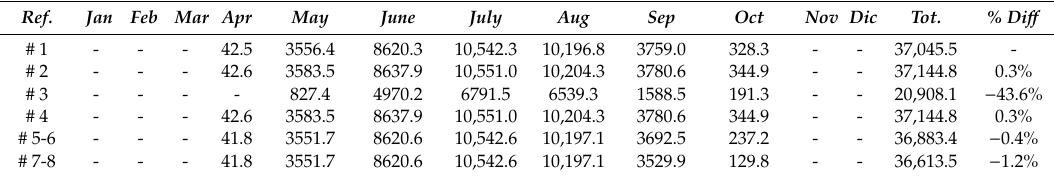
Table 5. Monthly thermal energy requirement (kWh / month) for cooling, covered by the traditional generator.